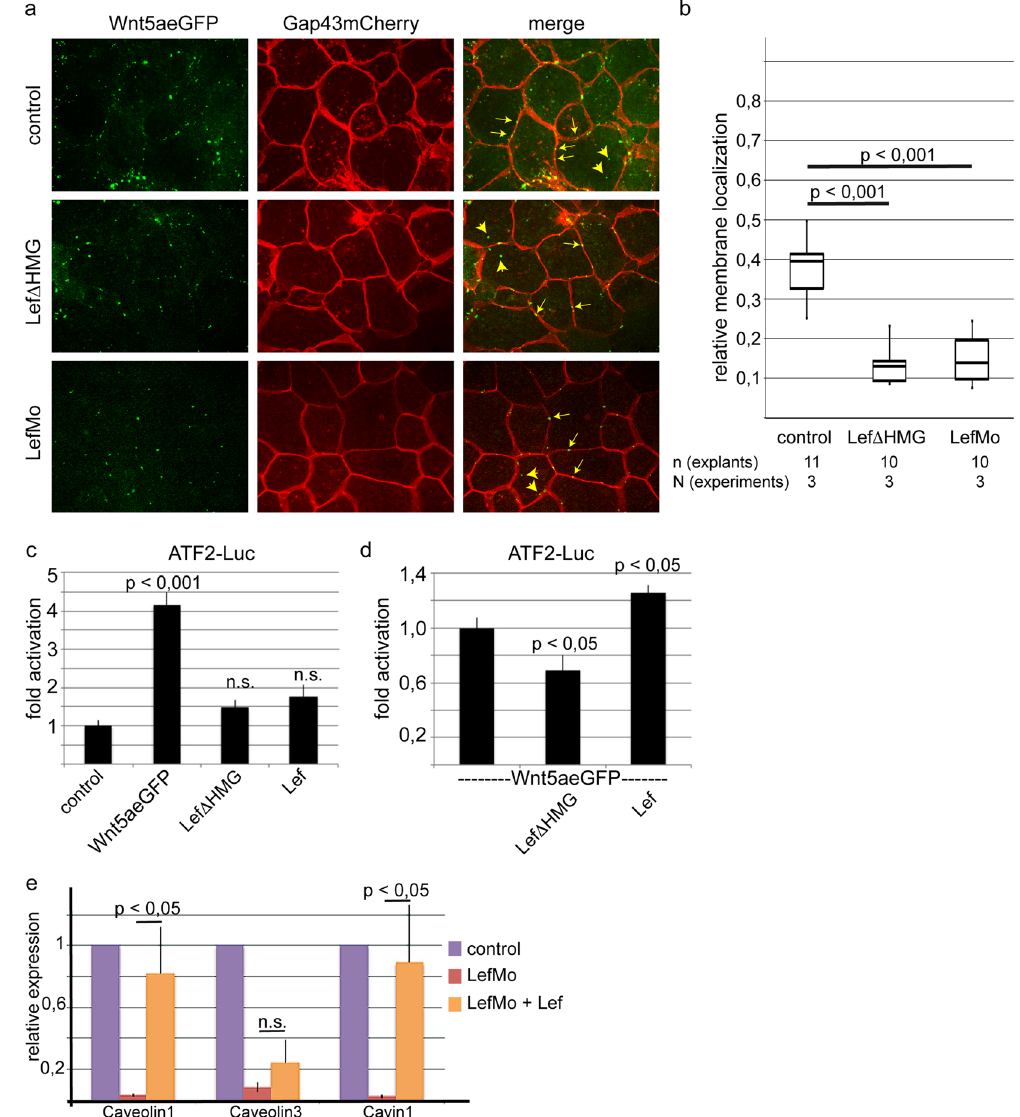
Figure 1. Lef1 regulates Wnt5a clustering and the expression of caveolin family members. (a ) Knock-down of Lef1 reduces the formation of Wnt5a clusters at the plasma membrane of DMZ cells. Both dorsal blastomeres of Xenopus 4-cell stage embryos were injected with 150 pg Wnt5aeGFP mRNA together with the membrane marker GAP43mCherry and 1 pmol of the Lef1 specific antisense morpholinos (LefMo) or 500 pg dominant negative Lef1 mRNA (Lef ∆ HMG). The arrows indicate some Wnt5a clusters located at the plasma membrane, arrowheads point to cytoplasmically located Wnt5a clusters. ( b ) Downregulation of Lef1 reduces the presence of Wnt5a clusters at the plasma membrane. Shown are the relative membrane localization according to Manders et al . 53 and the p values according to Student’s t-test. The images were processed using the Coloc 2 plugin in ImageJ which allows calculation of the Manders coefficient M2 53 . This coefficient indicates colocalization of Wnt5aeGFP clusters and the red coloured membrane. ( c ) In transfected HEK293 cells, Lef1 ∆ HMG and wild- type Lef1 do not significantly regulate the non-canonical Wnt reporter ATF2Luc. ( d ) In Wnt5a stimulated cells (cotransfected with Wnt5aeGFP), Lef1 ∆ HMG represses ATF2Luc activity. Wild-type Lef1, instead, activates the ATF2Luc reporter. p values of at least nine independent transfections were determined according to Student’s t-test. e) Real-time RT-PCR confirmed that the expression of cavin1, caveolin1 and caveolin3 are downregulated in Lef1 morphants and partially restored in morphants co-injected with 500 pg Lef1 mRNA. Shown are mean values and standard error of four biological